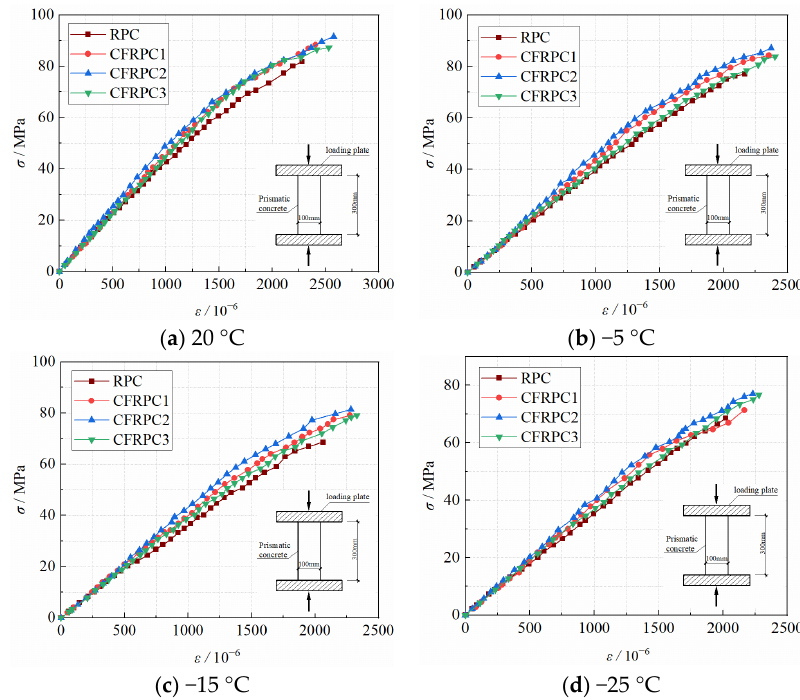
Figure 27. Stress–strain curves of CFRPC with different CF contents.